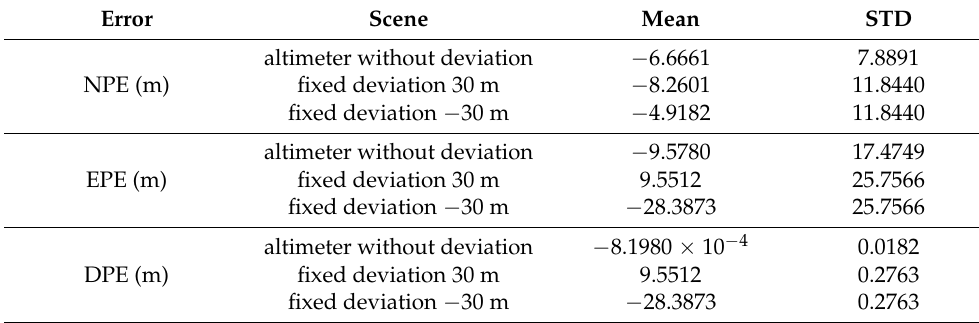
Table 5. Position error statistics.